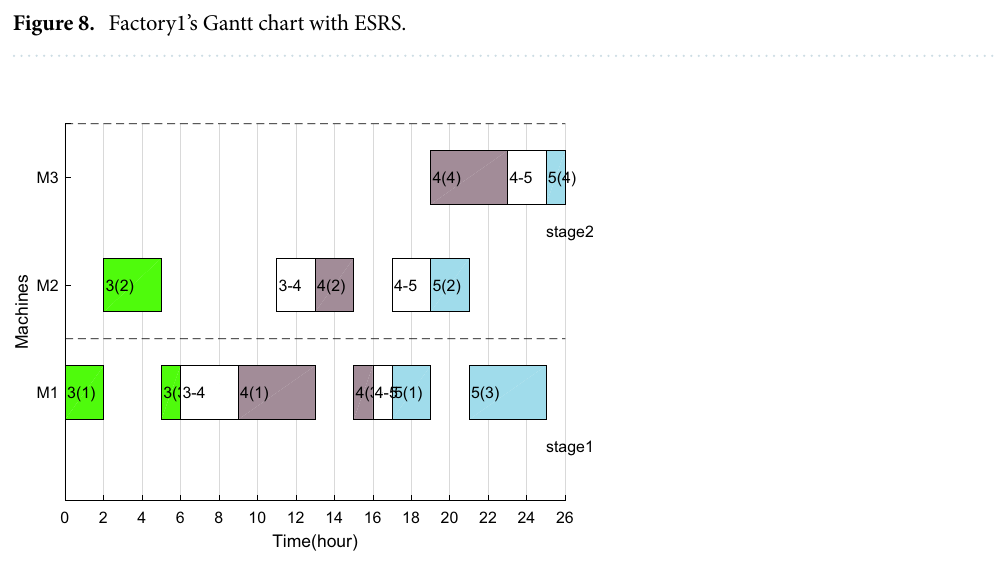
Figure 9. Factory2’s Gantt chart with